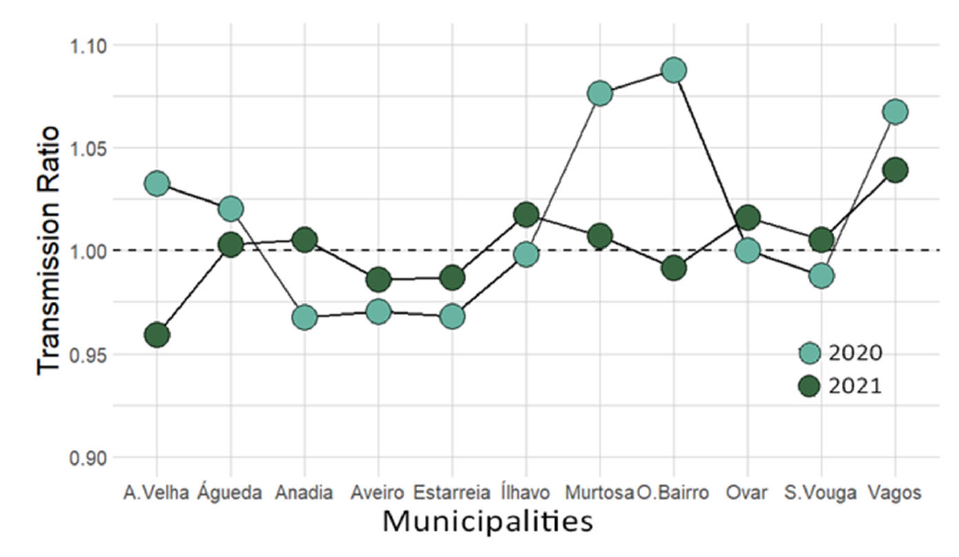
Figure 2. Transmission ratio regarding the municipality data for 2020 and 2021.